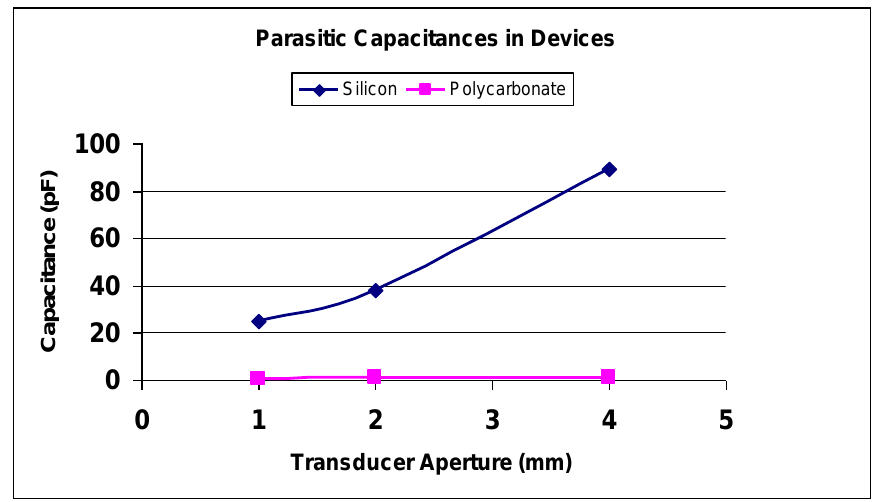
Figure 5. Measurements of parasitic capacitance with silicon and polycarbonate. It can be seen that silicon devices have higher capacitances compared to polycarbonate